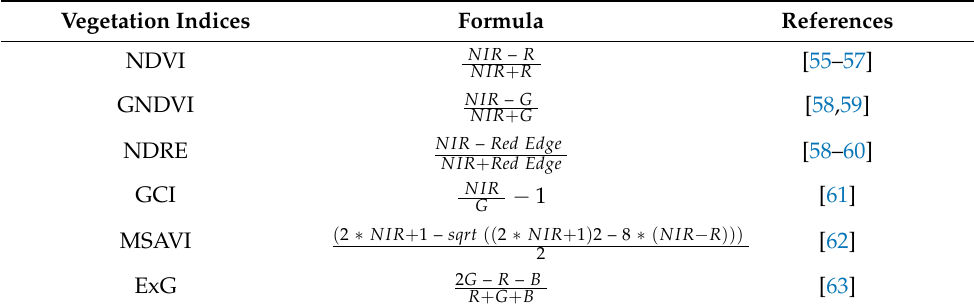
NDVI: Normalised Difference Vegetation Index; GNDVI: Green Normalised Difference Vegetation Index; NDRE: Normalised Difference Red Edge Index; GCI: Green Chlorophyll Index; MSAVI: Modified Soil-Adjusted Vegetation Index; ExG: Excess